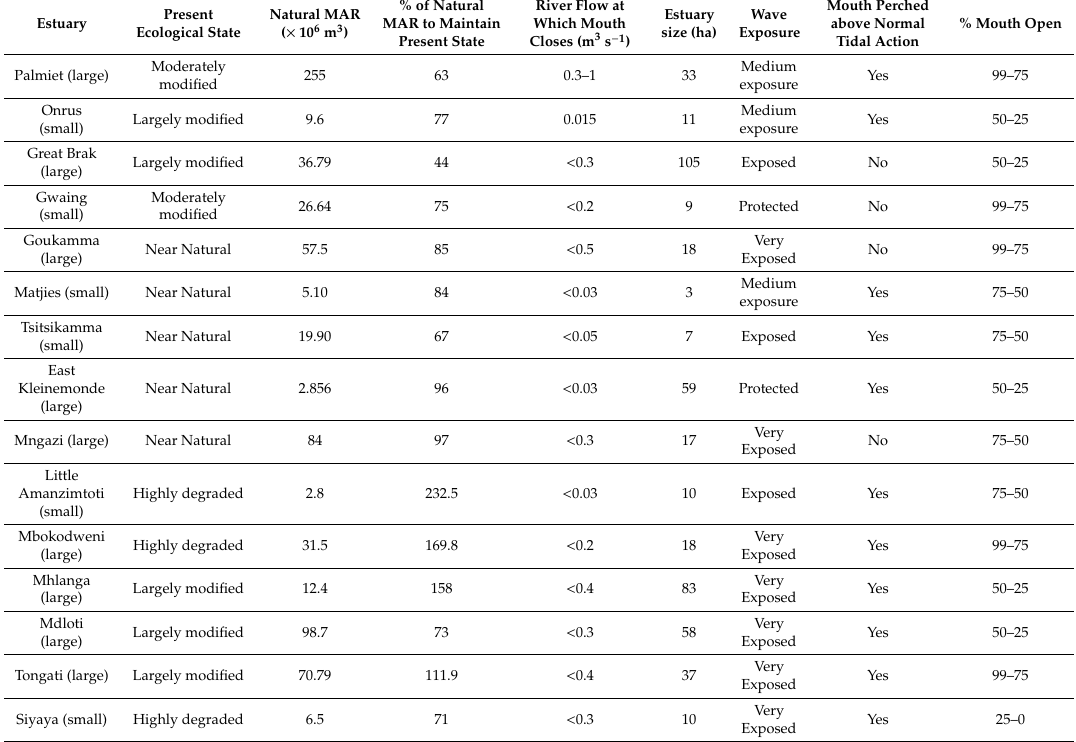
Table 4. Relevant data on the percentage Mean Annual Runo ff remaining, and flow required to maintain an open mouth in temporarily closed estuaries. Estuary size (ha) is provided as a proxy for tidal flows, while wave exposure is rated from very exposed to protected. Mouth constriction (perched above normal tidal action) is indicated and the resultant annual percentage open mouth conditions are provided as an indication of the interplay between runo ff , tidal flows, and wave exposure. These data were extracted for each estuary from reports of the Department of Water A ff airs. Estuaries are listed from west to east (Figure 2) and are classified as large and small temporarily closed, as per [8]. Present NaturalMAR EcologicalState ( × 10 6 m 3